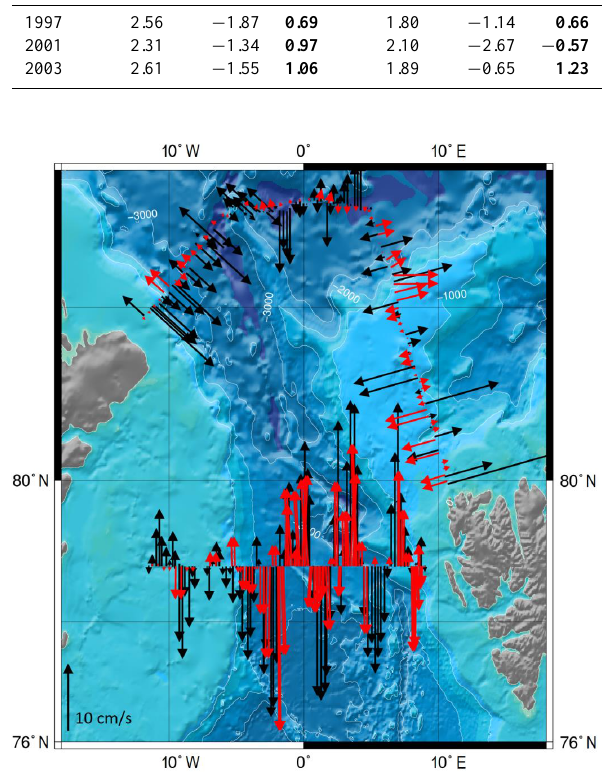
Fig. 9. Velocity vectors at approximately 160m depth from geostro- Fig. 9 phy with constraints applied (red) and from vessel mounted ADCP at 0.25 ◦ intervals (black) with only the velocity component approx- imately normal to the hydrography sections (northern section is di- vided into 3 subsections for averaging the directions) shown. Map produced with GMT (Wessel and Smith, 1998).